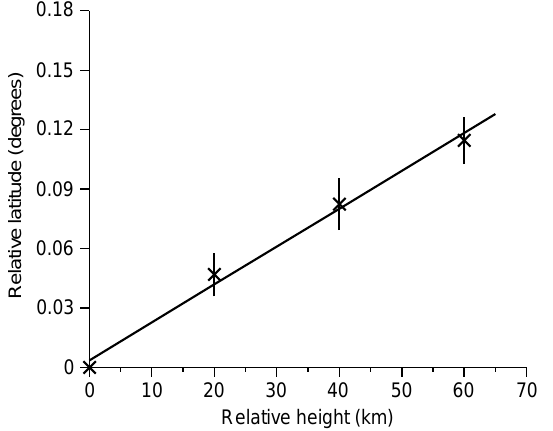
Fig. 6. Mean latitude of the poleward wall of the trough as a function of height, plotted with respect to that at a height of 240 km. The error bars indicate plus and minus one standard deviation for the 21 sets of observations used in the study